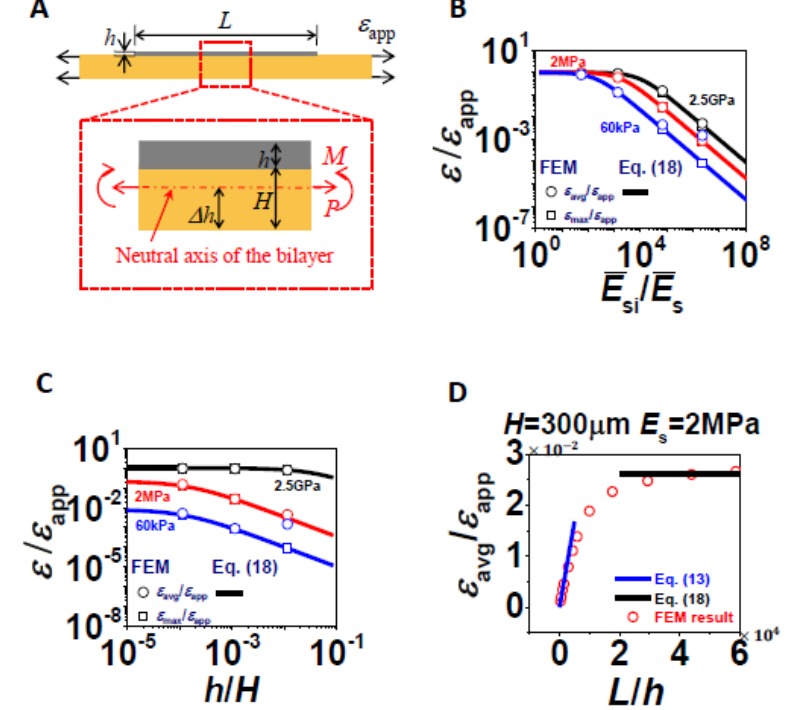
Figure 6. Comparison of Equation (18) and FEM results of ε L / H >> 1. ( A ) Schematic of the FBD of a section of thin silicon strip bonded to